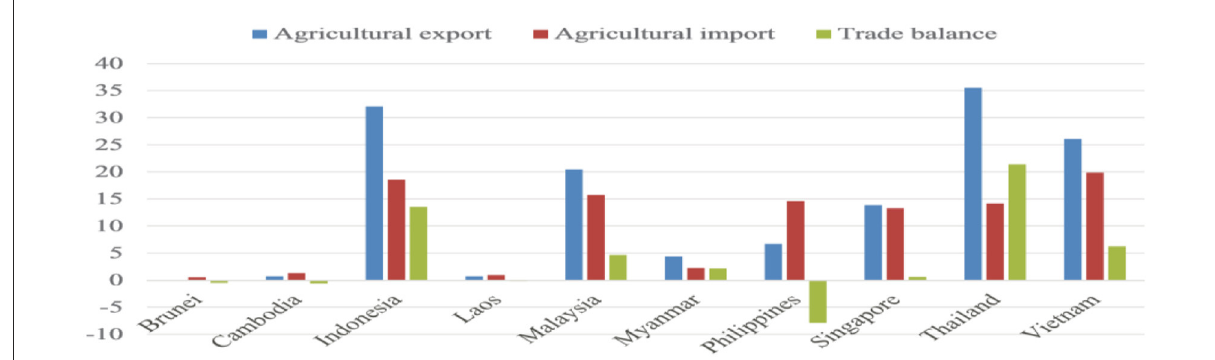
FIGURE2 The ASEAN economies trade USD billion (World Integrated Trade Solution,